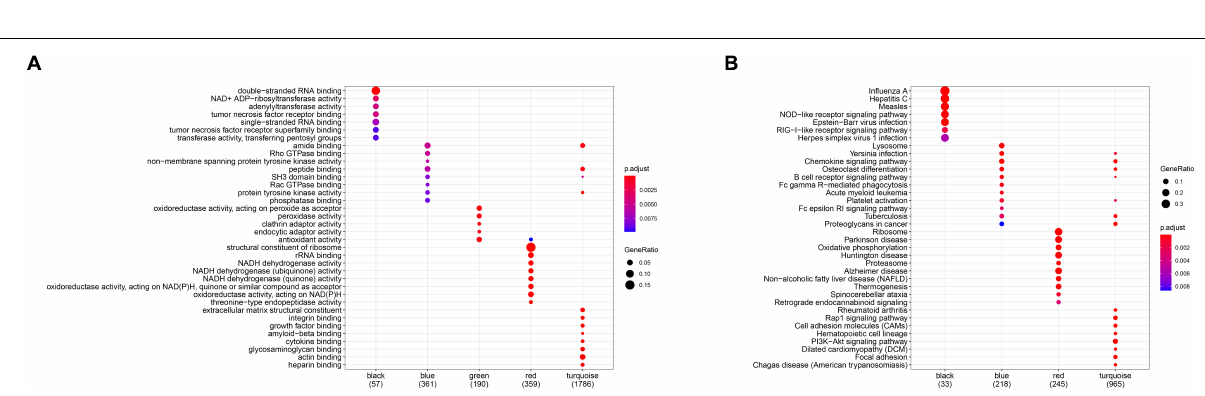
Frontiers in Molecular Biosciences |